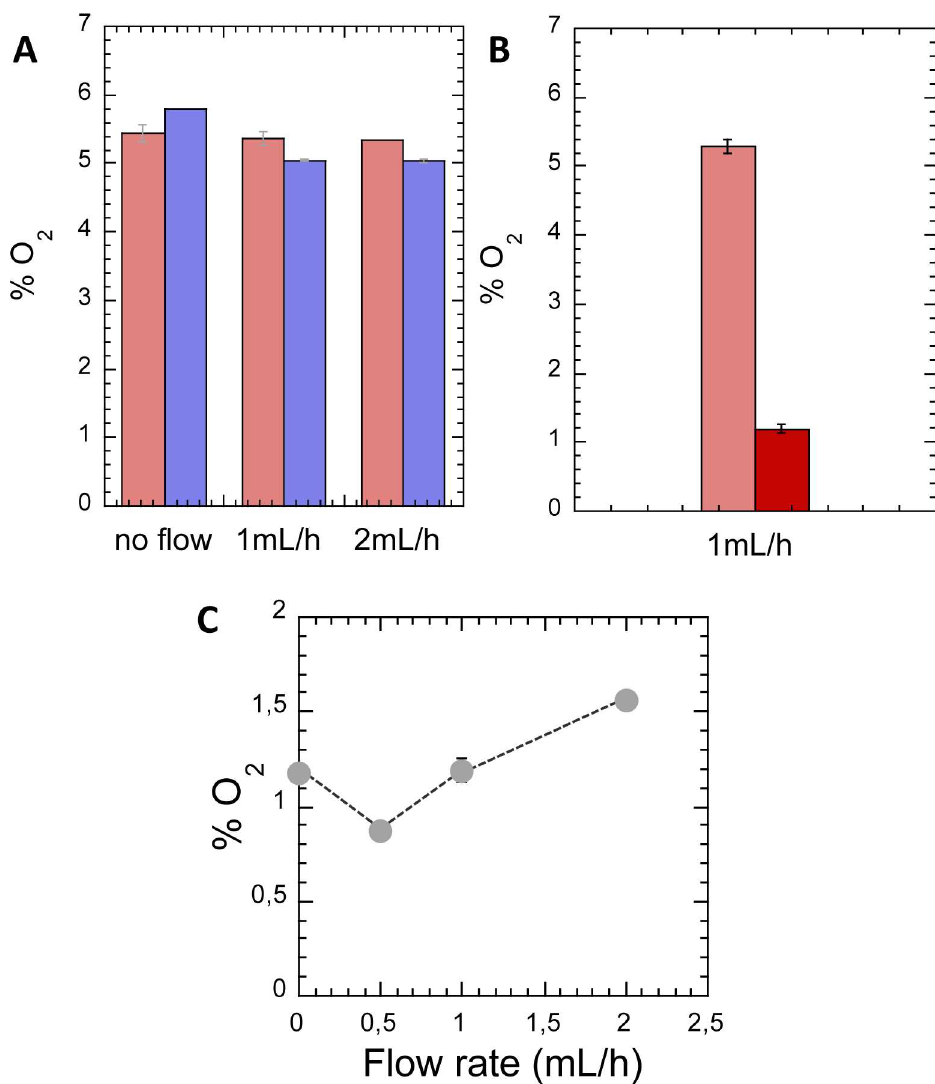
Fig 8. Biofilm grows at low O 2 level in a millifluidic channel. Oxygen partial pressure( p O 2 ) is measuredin the channelfluid using Rutheniummicellesfluorescence (see Materials and Methods). (A) p O 2 in empty channels at different flow rates (0; 1 and 2 ml/h), in 250 μ m- (red) and 1 mm- (blue) height channels.(B) p O 2 in 250 μ m- height channelat 1 ml/h, in the presence(dark red) or absence(light red) of a growingbiofilm 12 hours after initiation.(C) p O 2 vs. flow rate in a 250 μ m—height channelin the presenceof the growingbiofilm. Error bars (smaller than dots in C) represent standard deviationover two